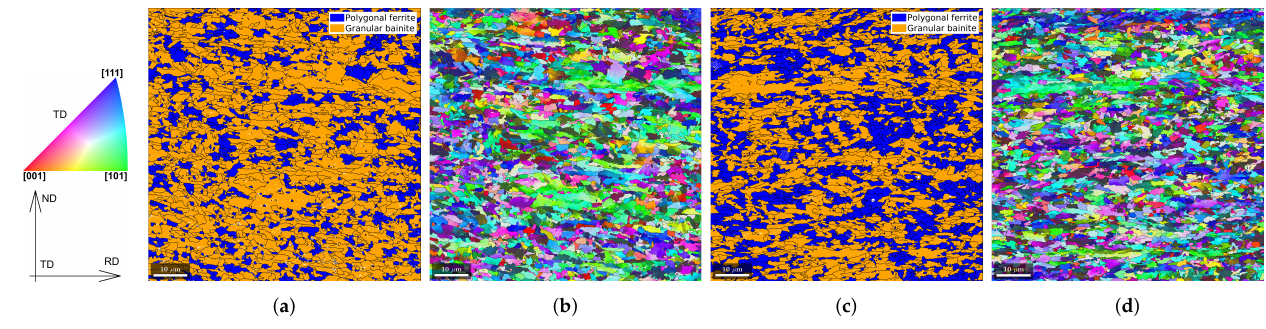
Figure 2. An EBSD scan and a phase map are shown in ( a , b ) for material S 1 and in ( c , d ) for material S 2 . EBSD scans are colored by their IPF. Phase maps, showing polygonal ferrite and granular bainite phases, were calculated from the EBSD scans with the classification tool described in work by Jentner et al. [25]. The grain boundaries are colored in